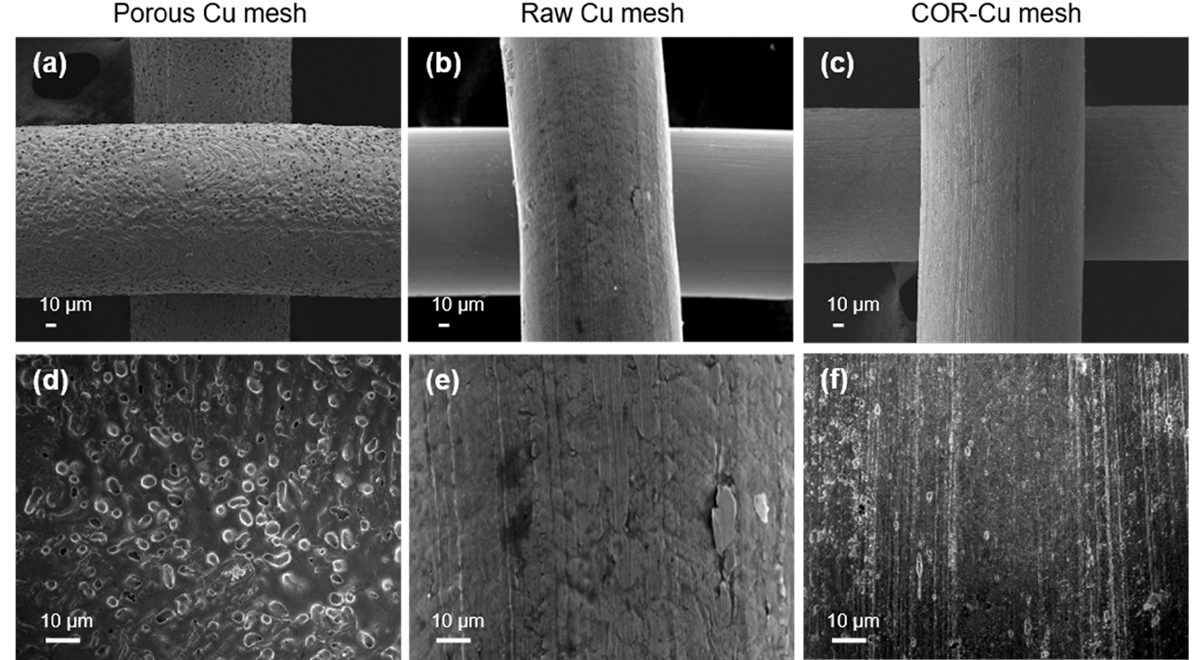
Figure 2. SEM images of ( a , d ) P-Cu, ( b , e ) raw Cu (R-Cu), and ( c , f ) bare Cu (B-Cu) meshes. ( d – f ) High-magnification images of each Cu mesh.